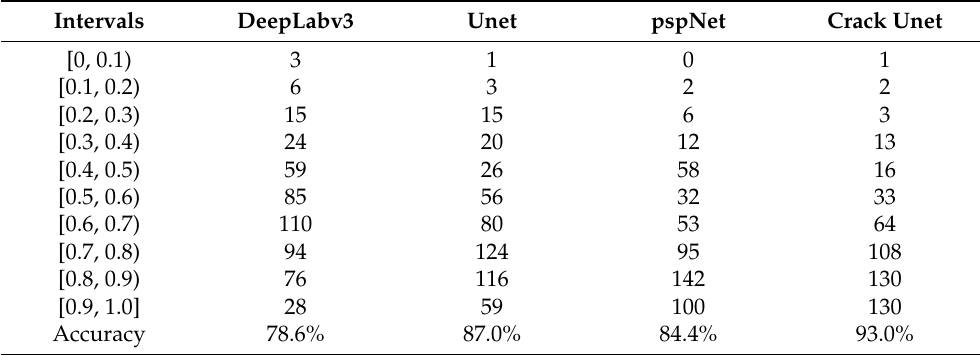
Table 3. The segmentation results of each model in the crack test set and the quantity distribution in each coverage